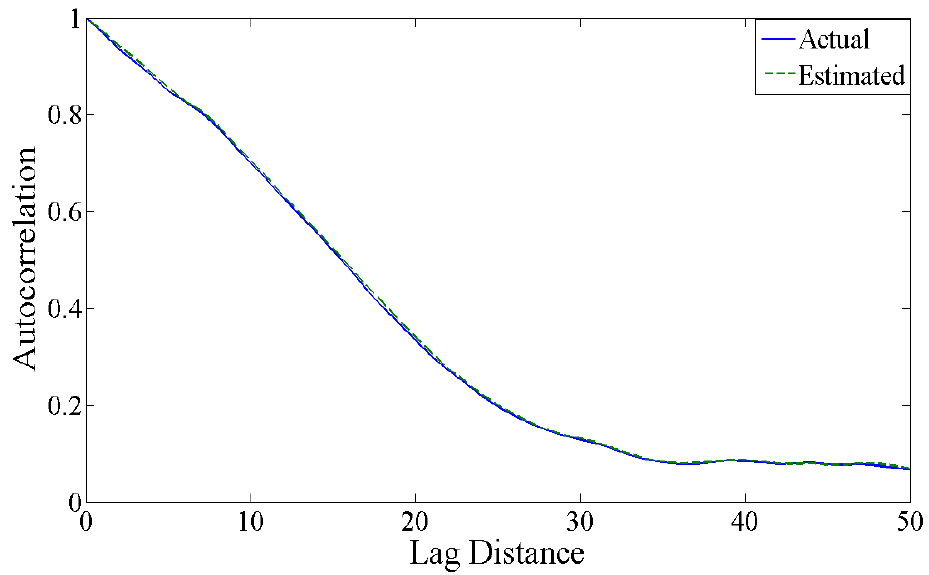
Figure 6. Actual and predicted gold price auto-correlation plots for the training data set.